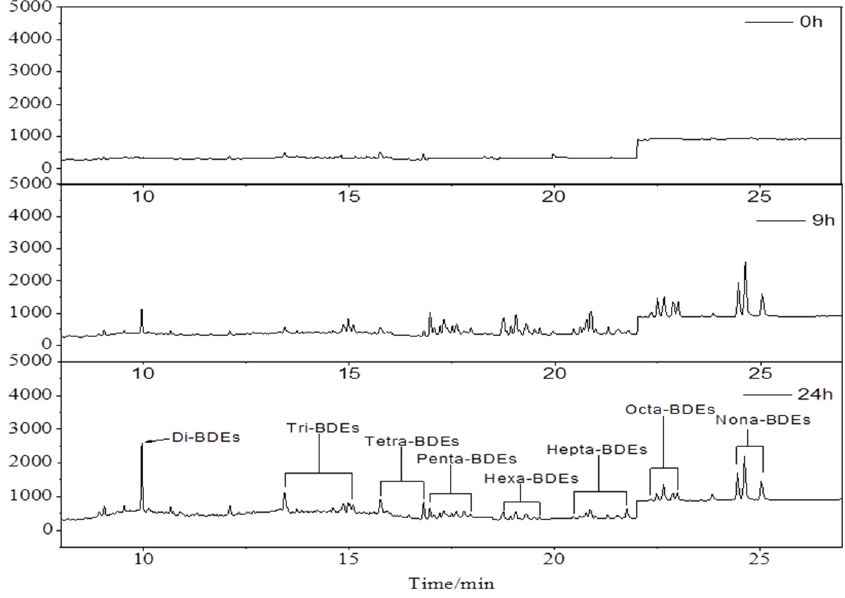
Figure 6. The products of BDE-209 in soil suspension after photodegradation.